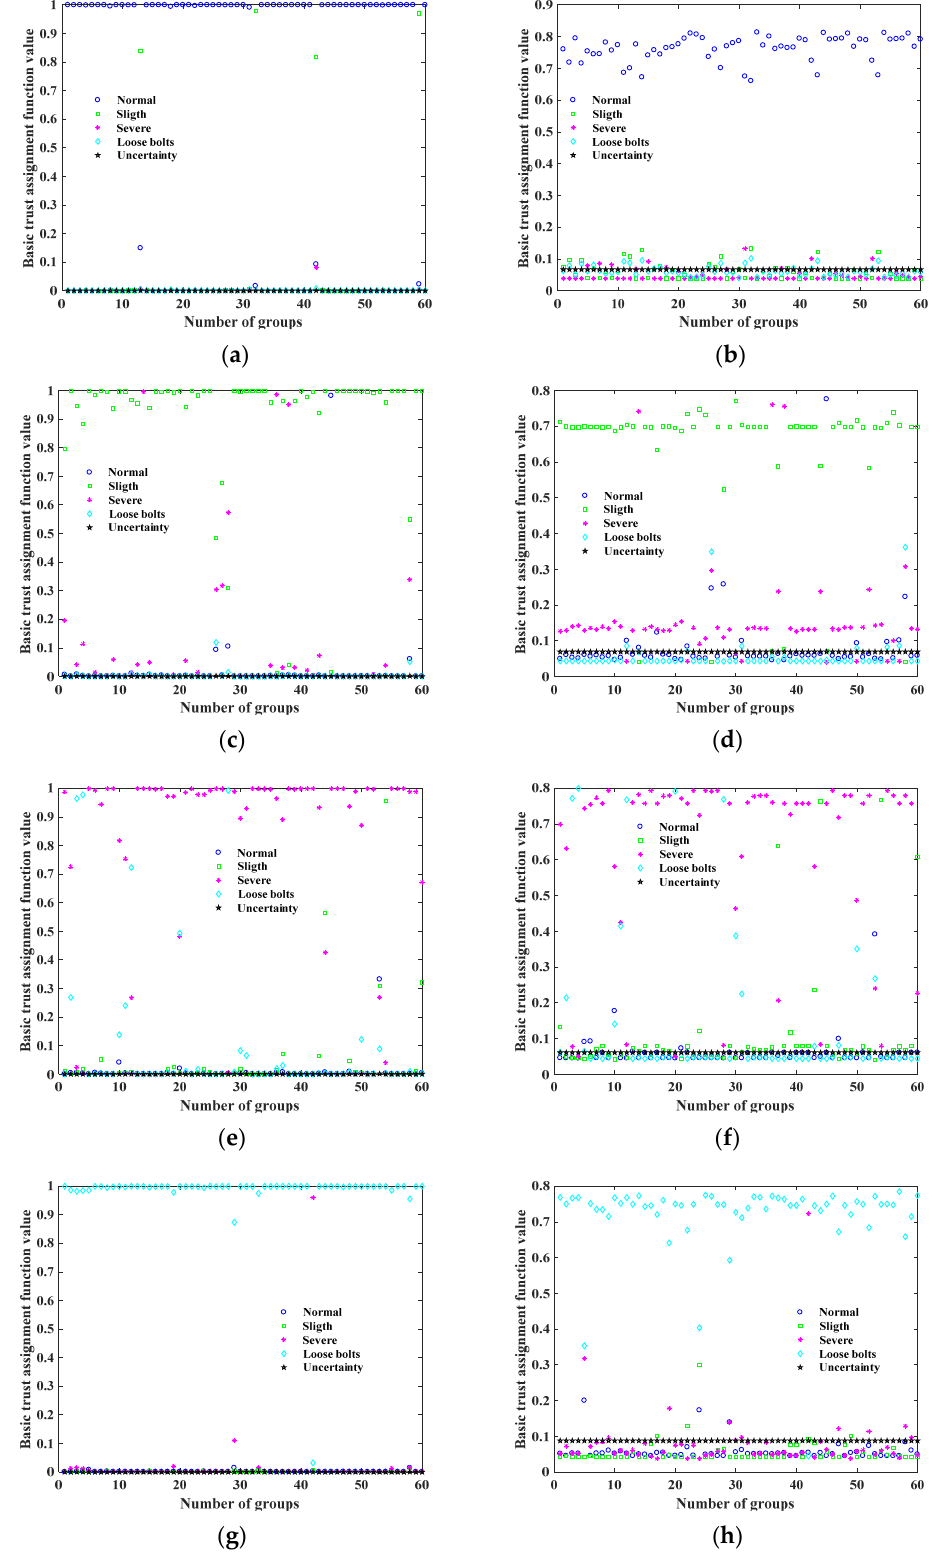
Figure 8. Analysis of recognition accuracy under ( a ) normal state by D-S evidence, ( b ) normal state by pump vibration signal, ( c ) slight cavitation by D-S evidence, ( d ) slight cavitation by torque signal, ( e ) severe cavitation by D-S evidence, ( f ) severe cavitation by motor vibration signal, ( g ) loose foot bolts by D-S evidence, and ( h ) loose foot bolts by D-S swing signal.